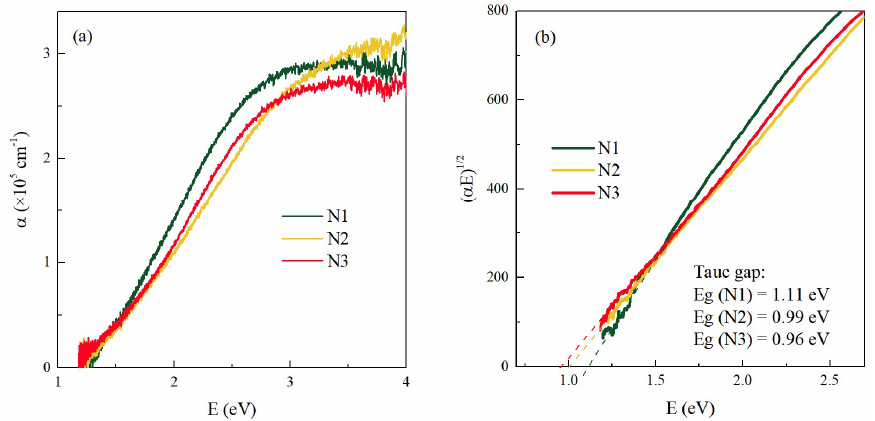
Figure 5. ( a ) The absorption coefficient of the films as a function of energy. ( b ) Tauc’s plot ( α E) 1/2 vs. energy was used to determine the bandgaps of thin films.